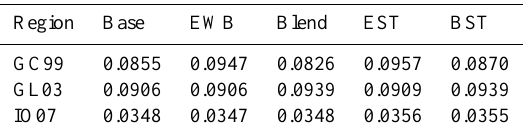
Table 3. Standard deviations associated with the mean temperature difference profiles for the three case studies.